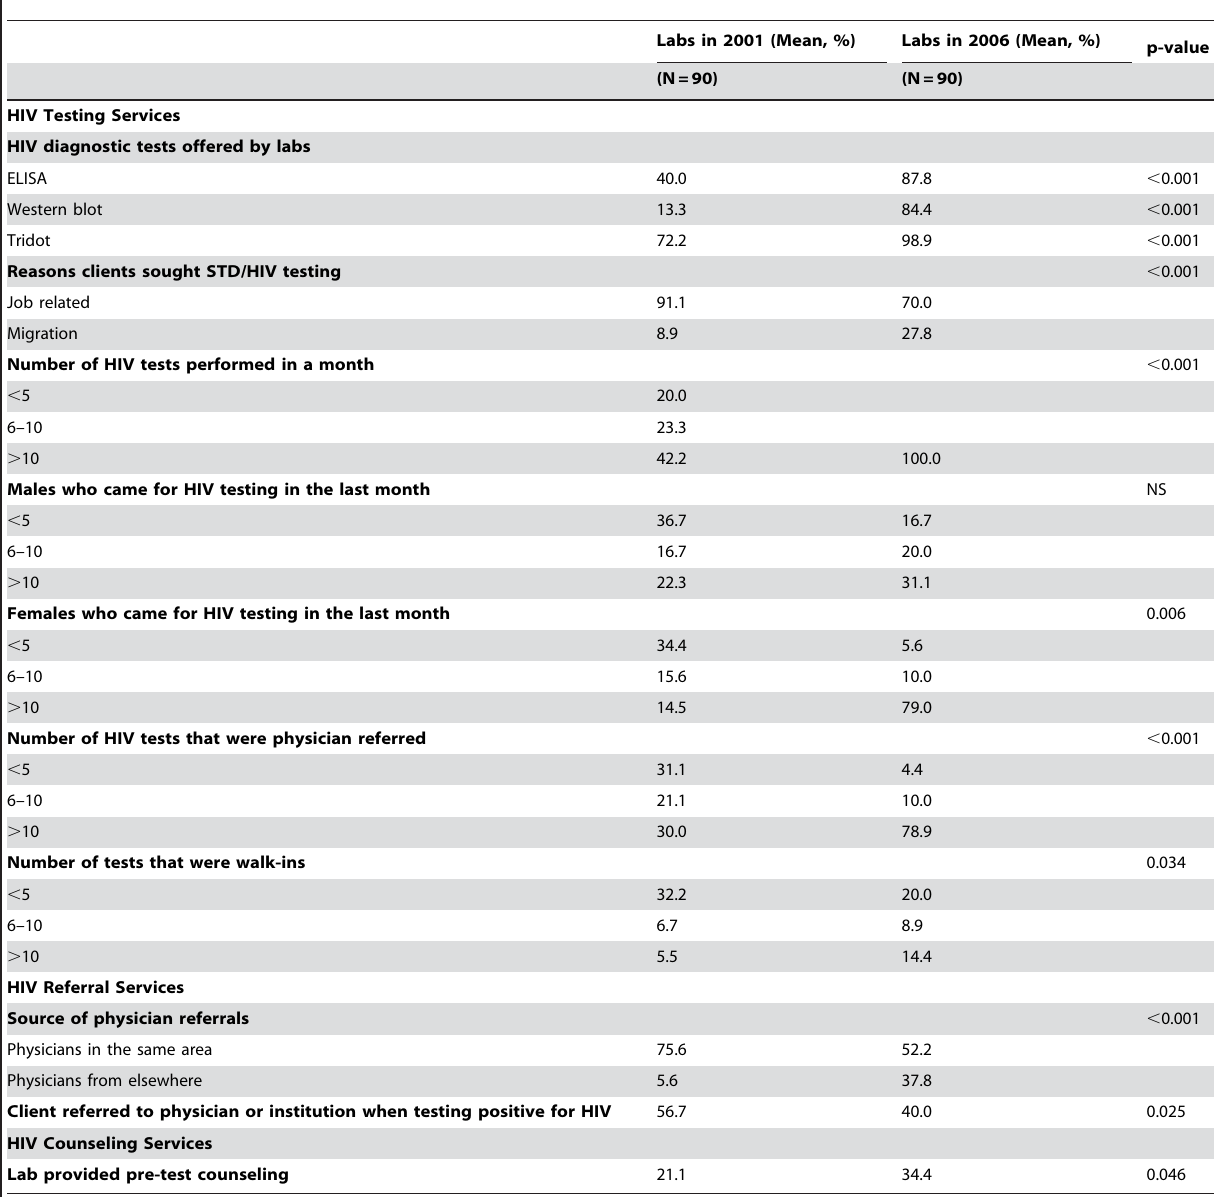
Table 2. Changing patterns in HIV testing, counseling, and clinical services from 2001 to 2006 (N